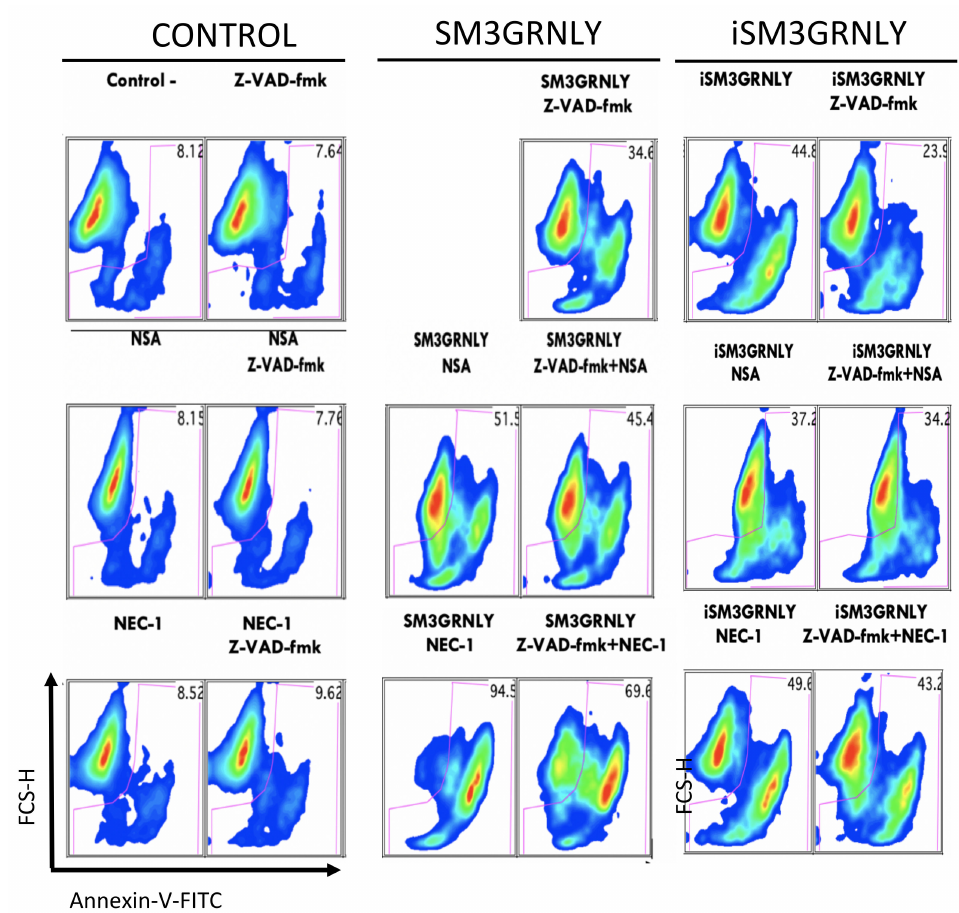
Figure 8. Study of the induction of death in JURKAT cells. Cells were preincubated for 1h in the presence or absence of 100 µ M Z-VAD-fmk, 30 µ M NEC-1 or 1 µ M NSA alone or in combination. Subsequently, they were incubated with 10 µ M of SM3GRNLY for 24 h and analyzed by flow cytometry by labeling with Annexin-V-FITC combined with the analysis of cell size in FSC-H. Representative images from two independent experiments are